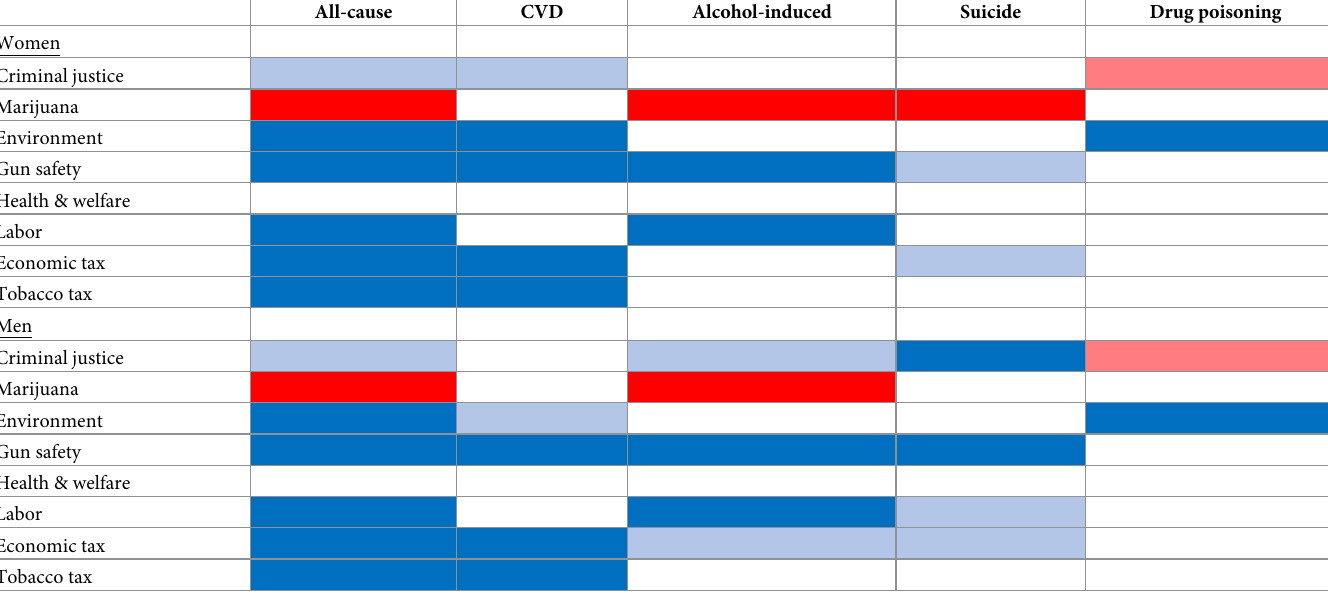
Table 2. Summary of the strength and direction of the association between a policy domain’s liberalism score and working-age mortality rates. All-cause